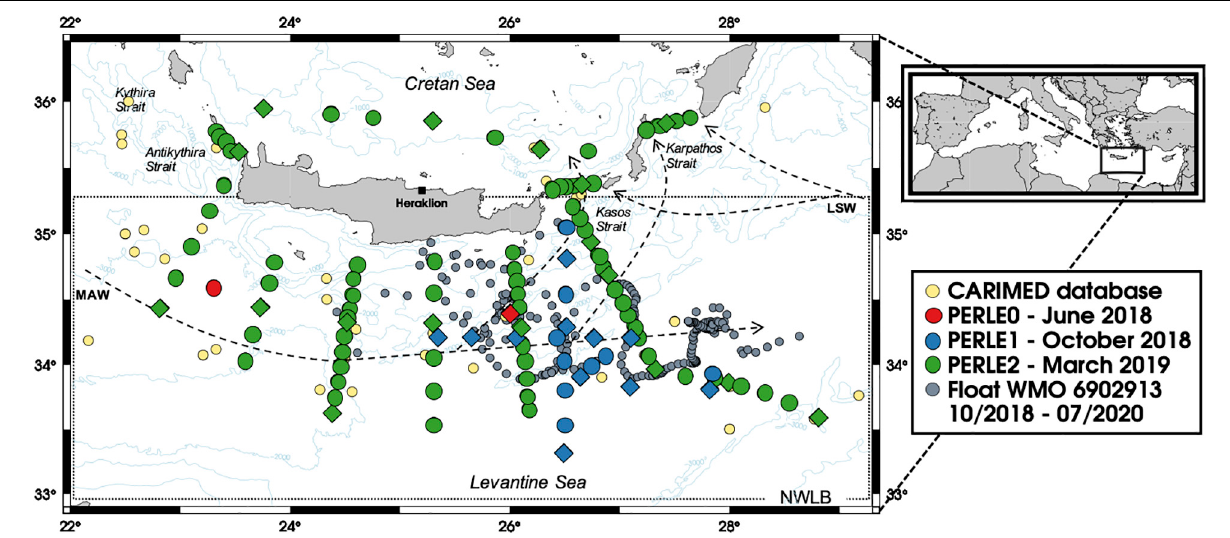
FIGURE 1 | Map of the “PERLE area.” Stations visited during PERLE0 are in red, during PERLE1 in blue and during PERLE2 in green. Diamonds represent stations with carbonate chemistry. Stations from the CARIMED database with A T and C T measurements are shown by small yellow dots. Grey dots show the WMO 6902913 Argo profiler positions from October 2018 to July 2020. Arrows show the main surface water mass pathways (see acronyms in the text). The North Western Levantine Basin area (NWLB) is defined by the dotted